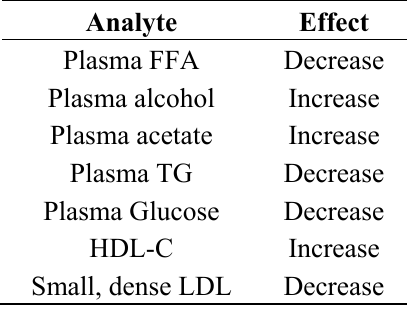
Table 1. Effects of Alcohol Ingestion on Lipids and their Metabolism.